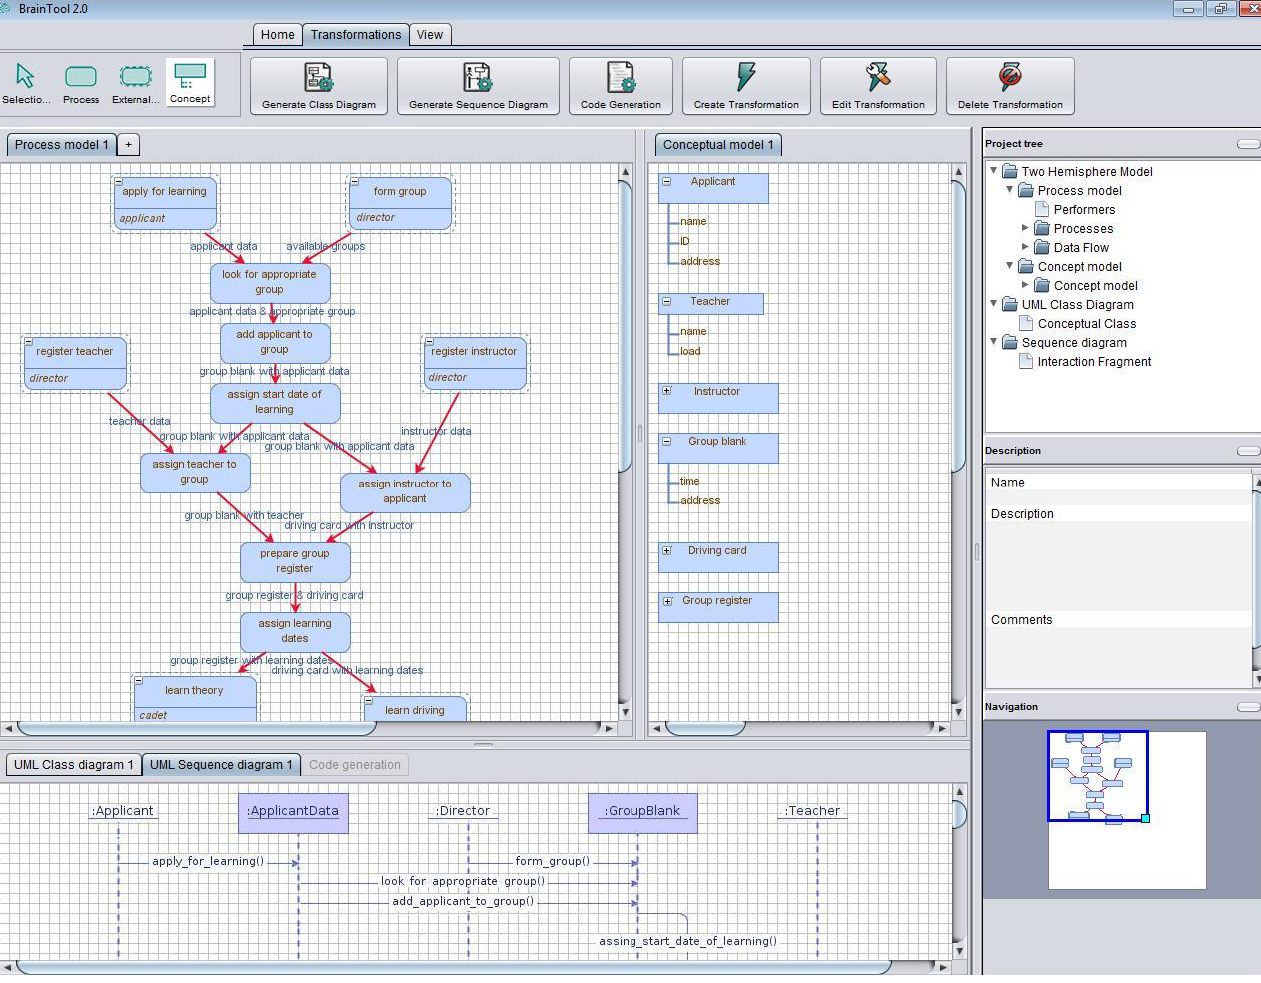
Fig. 1. General view of